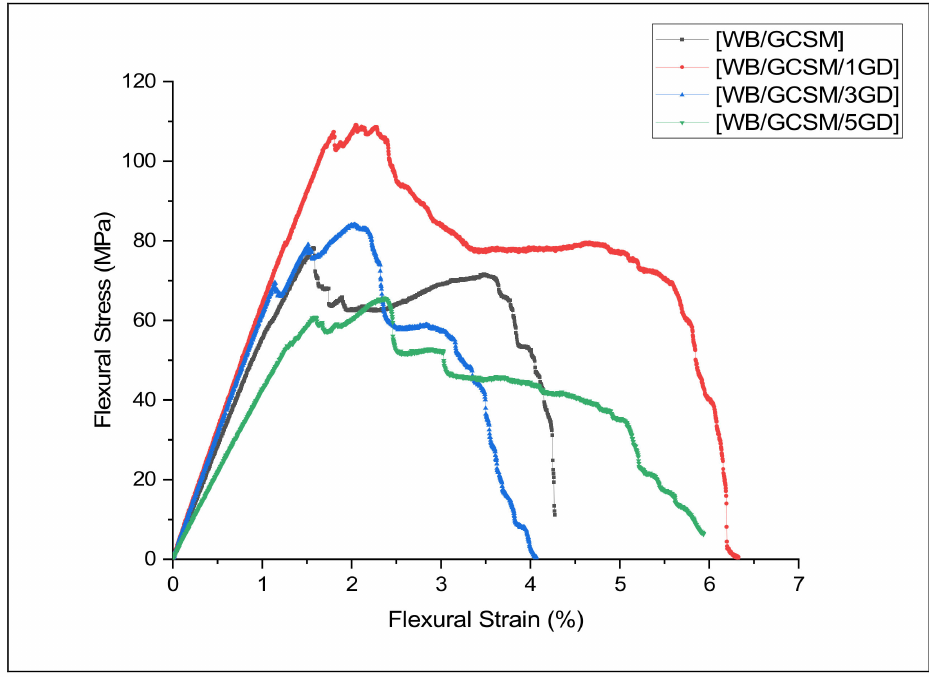
Figure 8. Typical flexural stress–strain curves for [WB/GCSM], [WB/GCSM/1GD],